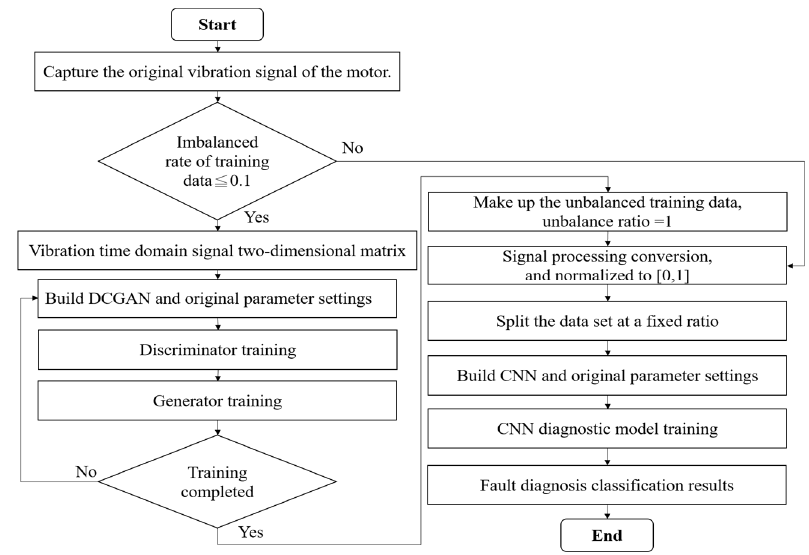
Figure 7. CNN architecture diagram.